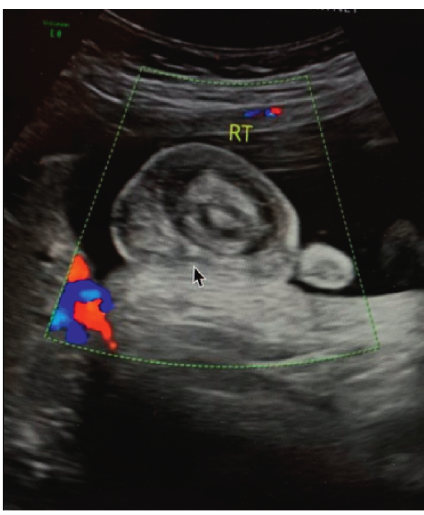
Figure 1: In utero fetal color Doppler ultrasonography demon- strating a sagittal view of right testicle at 36 weeks gestation, re- vealing a thickened scrotal wall (arrow) with reactive hydrocele surrounding a necrotic